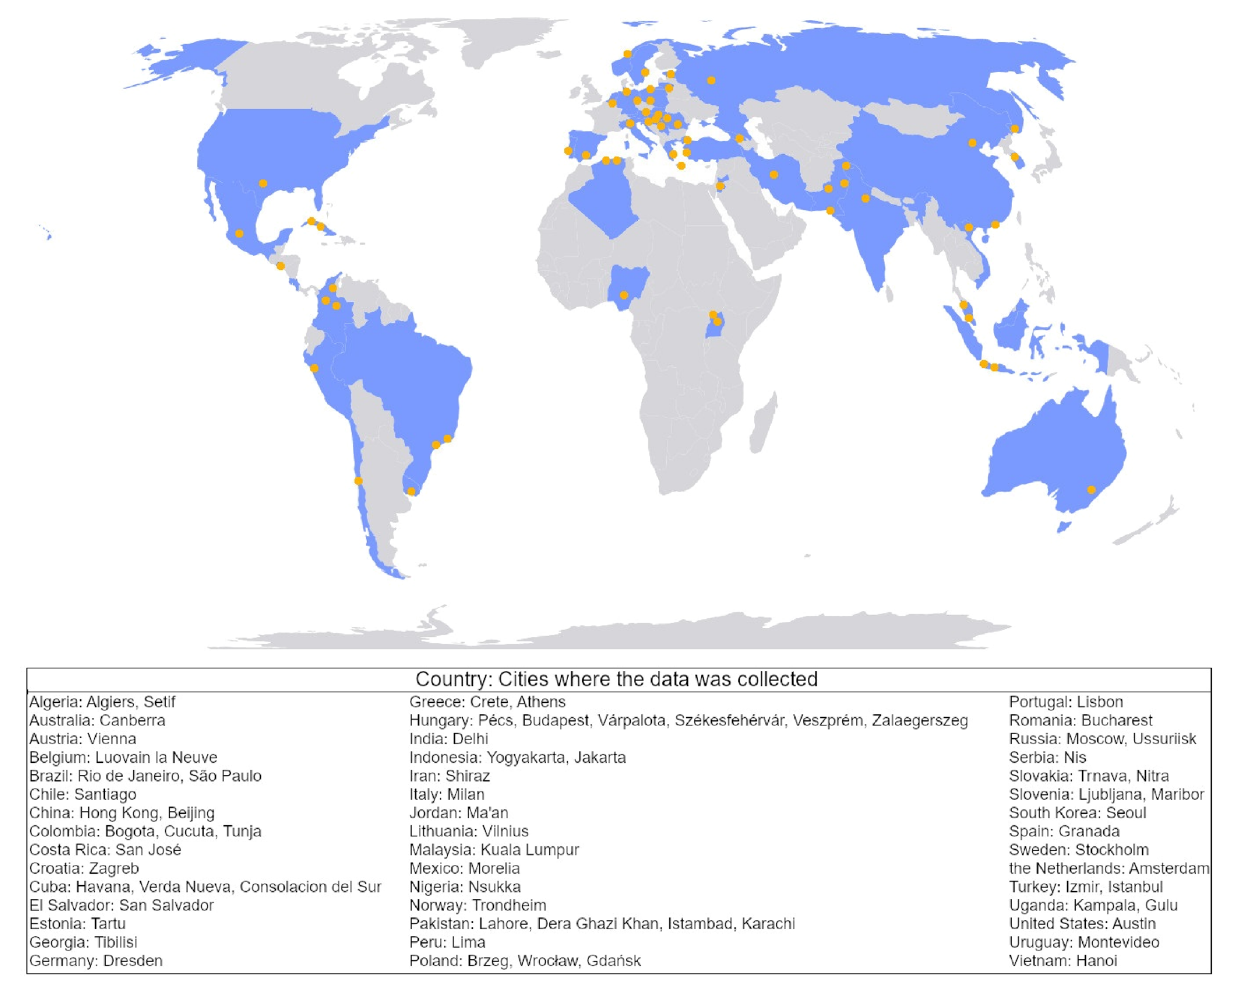
Figure 3. Locations of data collection. Countries (in blue) with corresponding study sites (cities in